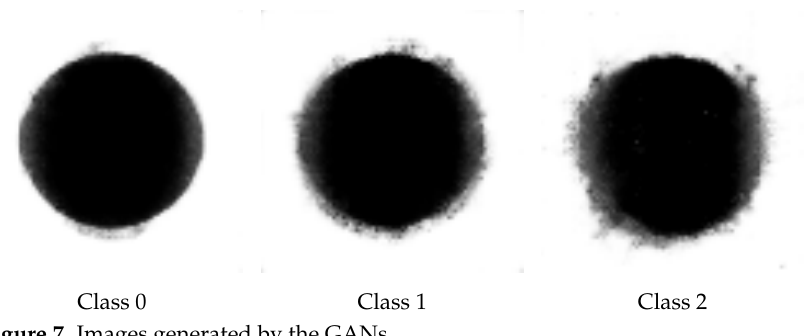
Figure 7. Images generated by the